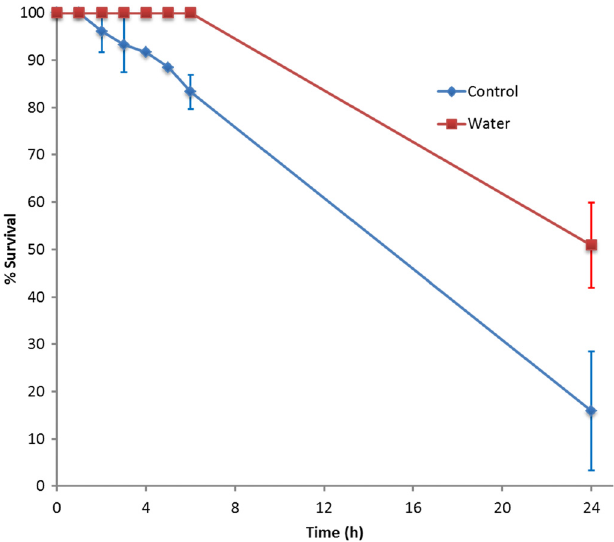
Figure 2. Survival of head lice after immersion in water for 1h to 6 h, and 24h compared with control lice maintained at ambient